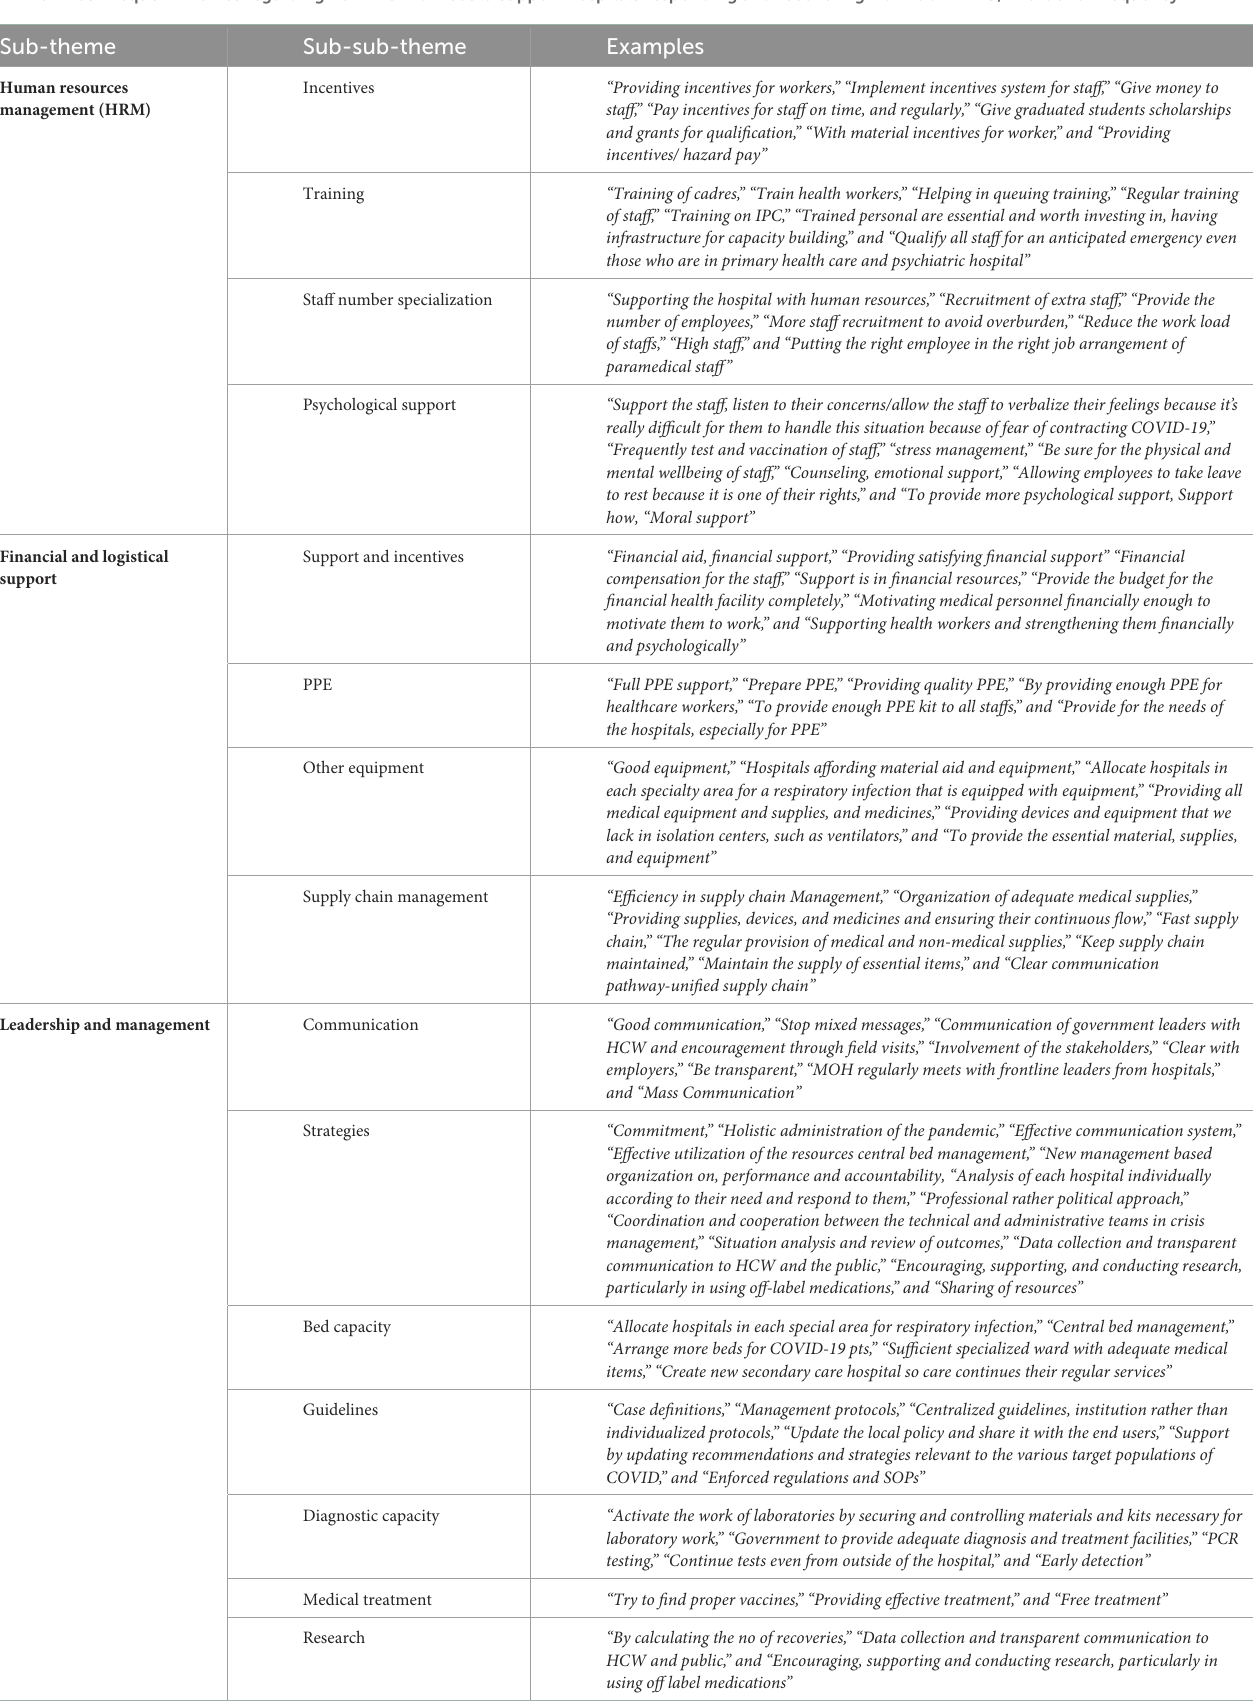
TABLE 3 Most frequent themes regarding how the MOH could support hospitals responding and recovering from COVID-19, in order of